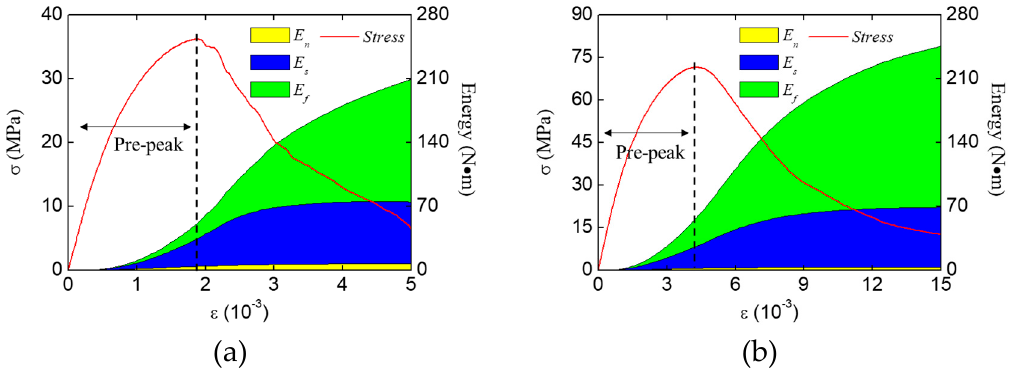
Figure 24. Energy evolution of the concrete specimen under compression with different specimen heights: ( a ) 200 mm, ( b ) 50 mm.